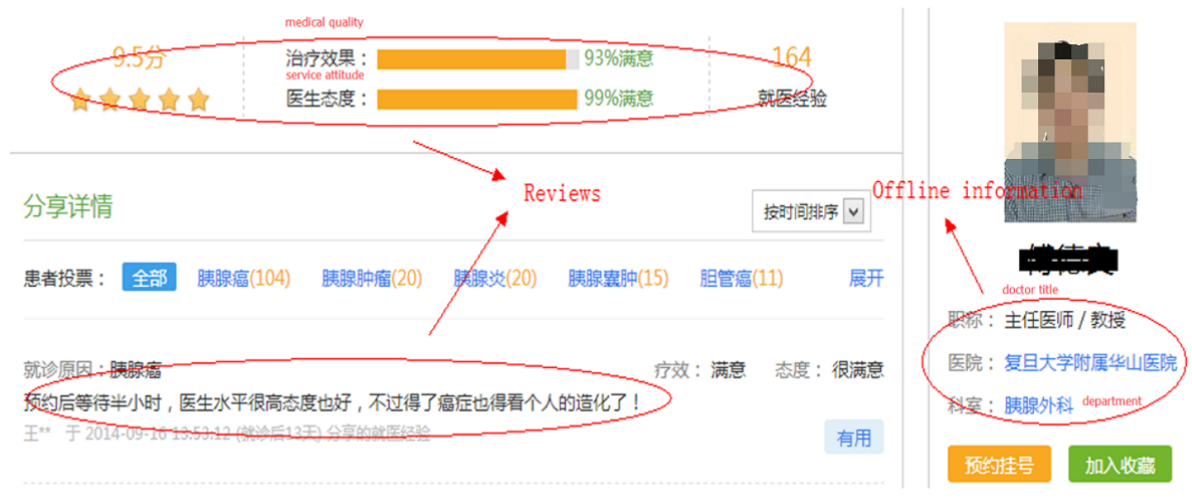
Figure 2. A doctor’s home page on the WeDoctor website.